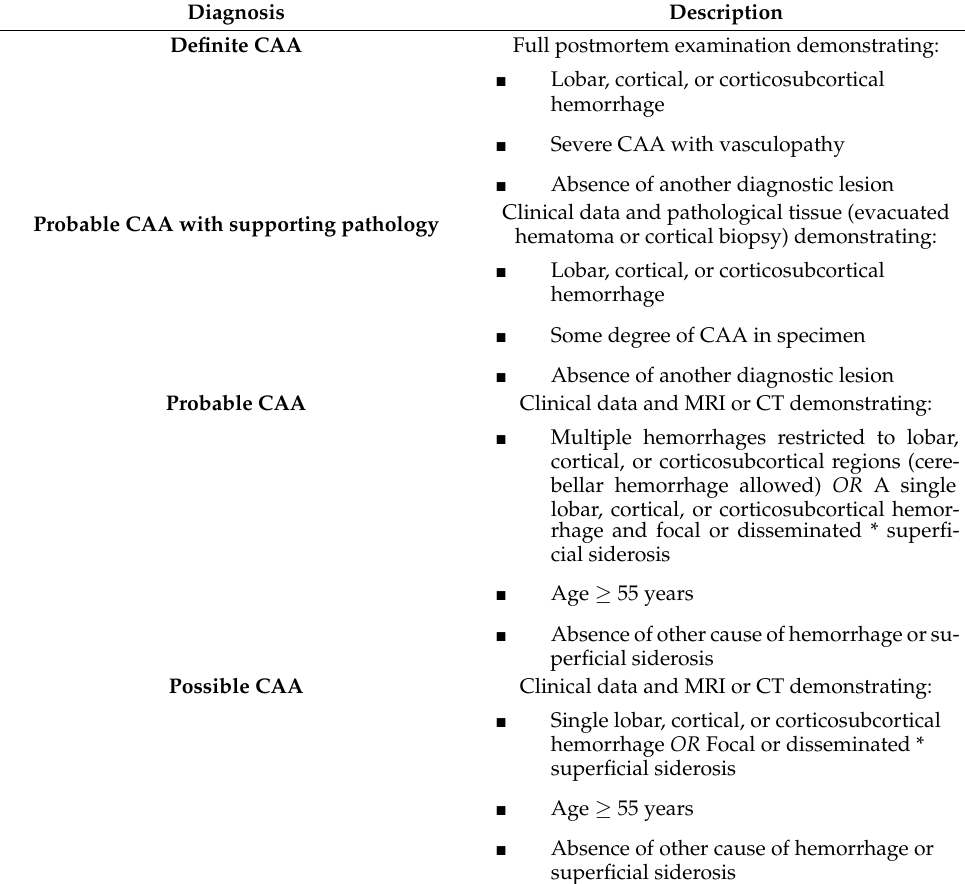
Table 1. Modified Boston criteria for CAA